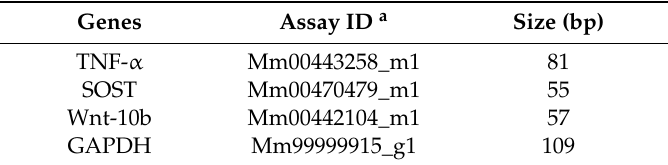
Table 1. Primers for real-time polymerase chain reaction (PCR). Genes Assay ID